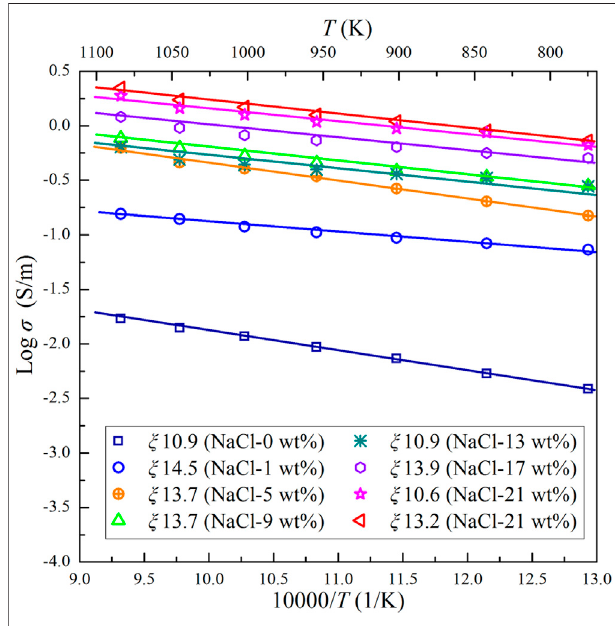
FIGURE 5 | Electrical conductivities of the Ol – NaCl – H 2 O system with a salinity of 0 – 21 wt% and fl uid fraction of 10.9 – 14.5 vol% at 2.0 GPa and 773 – 1073 K.